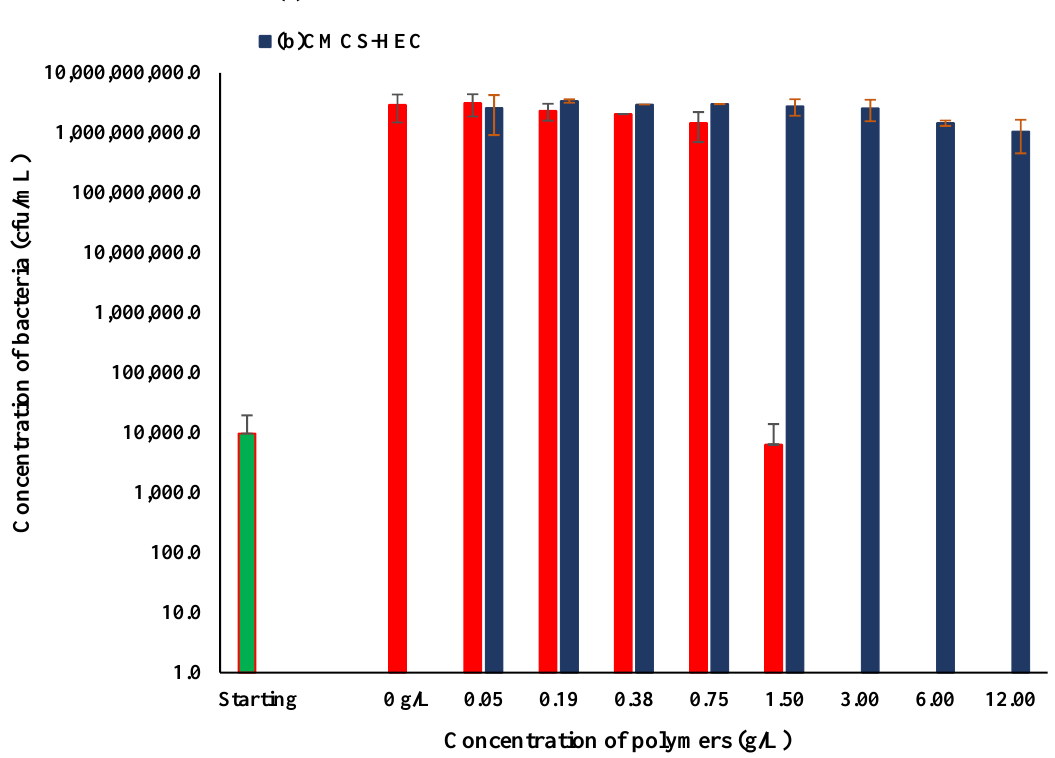
Figure 14. Minimum bacterial concentration (MBC) of alive E. coli 25,922 isolates after 23 h in the presence of (a) PDA-ZnO-CMCs-HEC and (b) CMCs-HEC hydrogels.